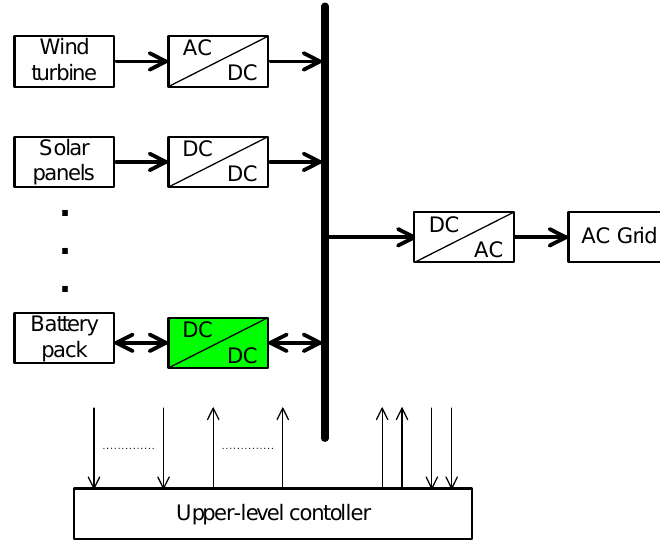
Figure 1. Typical structure of power electronics-based DC microgrid.